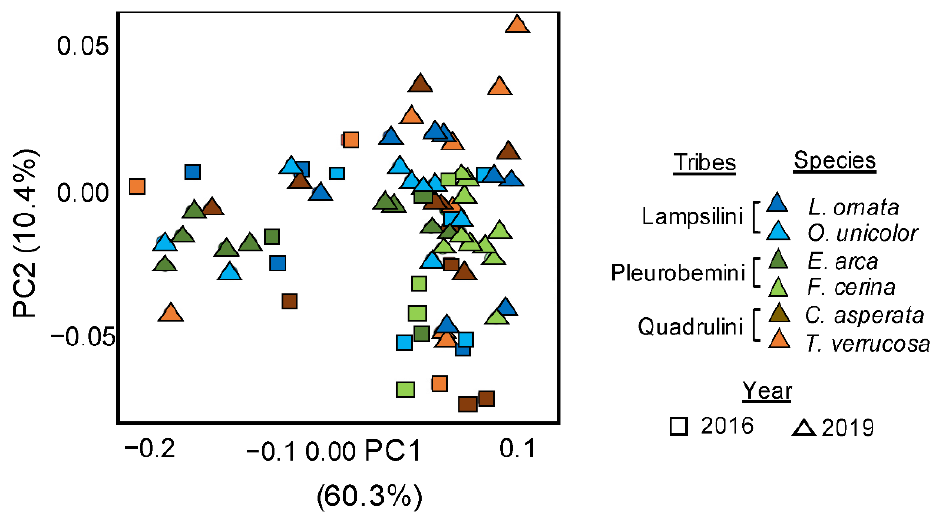
Figure 4. Principal co-ordinates analyses representing Bray–Curtis dissimilarities calculated from inferred functional pathways from 16S rRNA gene data between six species of Unionidae mussels sampled at the same site on the Sipsey River, AL, USA, across two years. Mussel species were Lampsilis ornata , Obovaria unicolor , Elliptio arca , Fusconaia cerina , Cyclonaias asperata , and Tritogonia verrucosa . The overall effects of species and year on microbiome structure were assessed using separated PERMANOVAs, with results ( p < 0.001 for all) indicated on each plot.